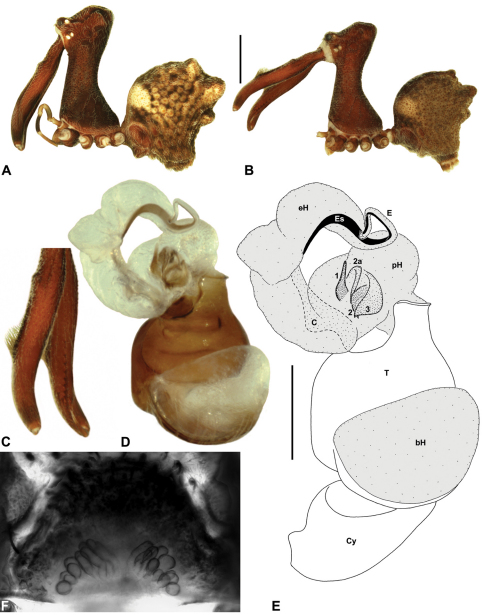
Austrarchaea mcguiganae sp. n. A–B, Cephalothorax and abdomen, lateral view: A, allotype female (AMS KS114975) from Monga National Park, New South Wales; B, holotype male (AMS KS62790) from Monga National Park, New South Wales. C, Holotype male chelicerae, lateral view, showing accessory setae. D–E, Holotype male pedipalpal bulb (fully expanded), retro-ventral view. G, Allotype female internal genitalia, dorsal view. bH = basal haematodocha; C = conductor; Cy = cymbium; E = embolus; eH = embolic portion of distal haematodocha; Es = embolic sclerite; pH = proximal portion of distal haematodocha; T = tegulum; (TS)1–3 = tegular sclerites 1–3. Scale bars: A–B = 1.0 mm; E = 0.2 mm.